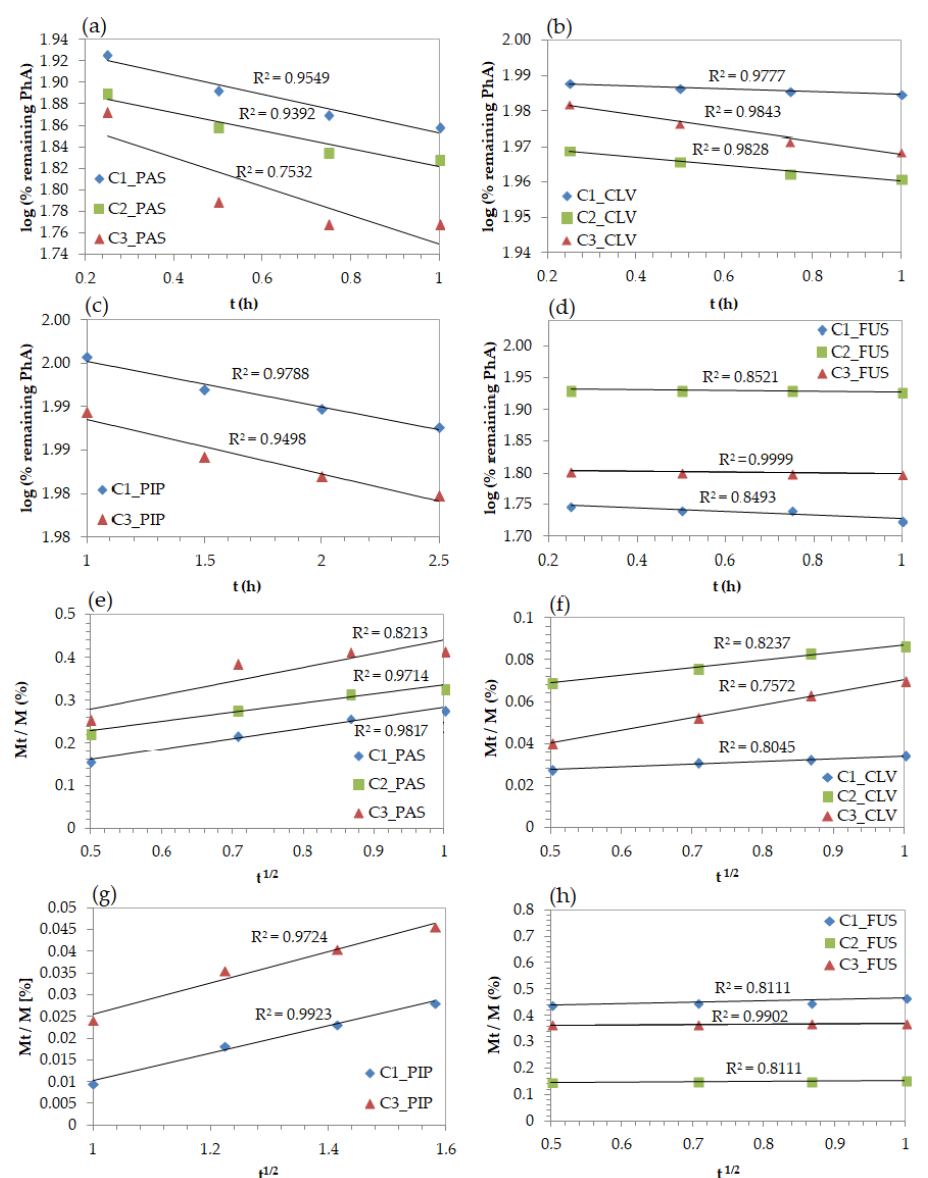
Figure 8. Kinetics profiles by models of first order ( a – d ), and Higuchi’s ( e – h ) for release of PAS, CLV, PIP, and FUS anions from conjugates based on PILs.